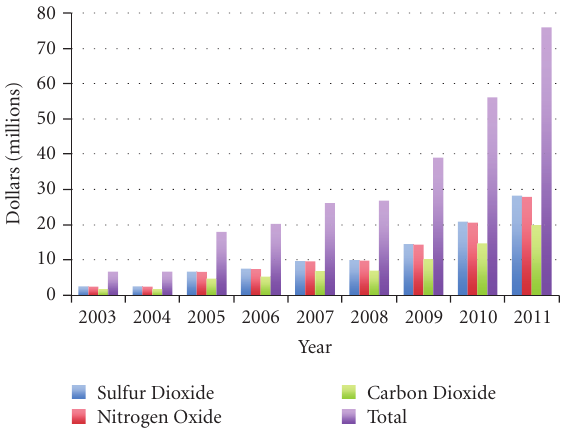
Nonfatal heart attacks ER visits